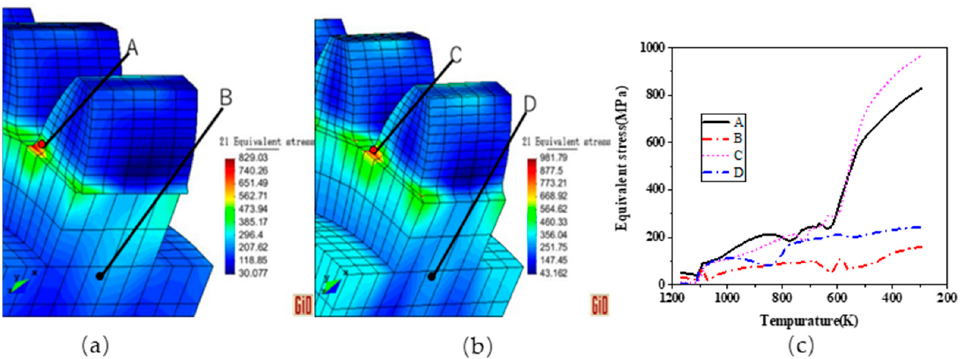
Figure 13. Equivalent residual stress results for 20CrMnTiH steel gears: ( a ) with transformation plasticity; ( b ) without transformation plasticity; ( c ) equivalent residual stress depending on temper- ature.